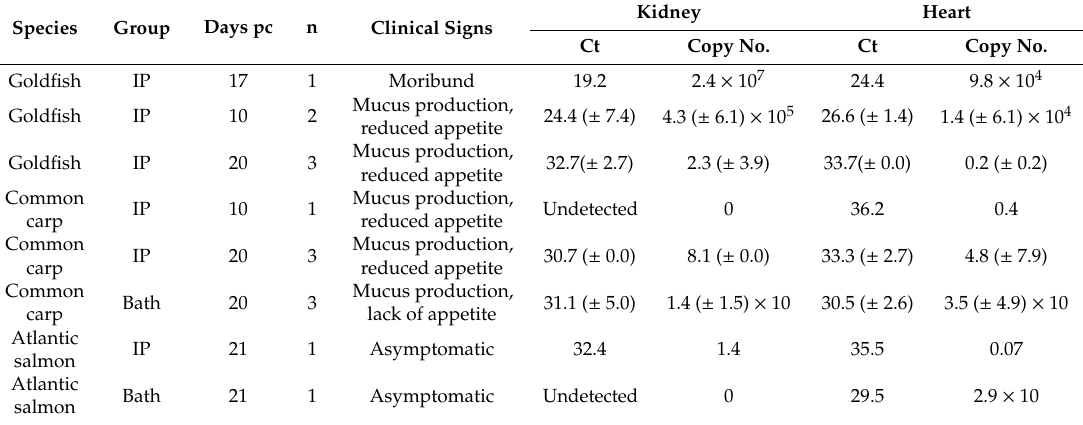
Table 6. Detection of the chinook salmon bafinivirus Cefas-W054 PpIa gene in challenged goldfish, common carp and Atlantic salmon sampled at di ff erent days post-challenge (pc). The route of infection was either via intraperitoneal injection (IP) or a bath challenge. Viral RNA was detected using RT-qPCR (Taqman). Ct: cycle number for positivity, Copy No: number of the viral PpIa copies calculated using a standard curve. n: number of fish per group